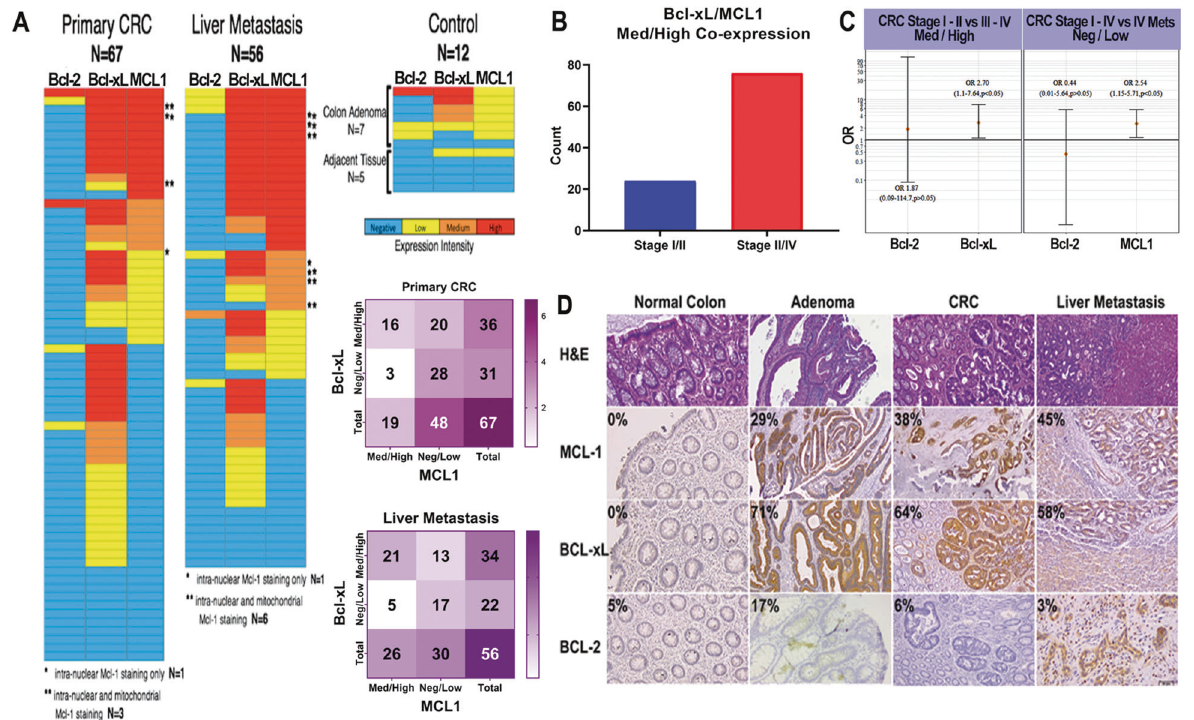
Fig. 5 Co-localization of overexpression MCL1 with Bcl-xL in clinical CRC samples. A Representation of protein expression for primary CRC and liver metastasis tissues. Rows represent individual patients. Primary CRC includes stages 1, 2, 3, and 4. Colon adenomas and adjacent tissues were used as control tissues. Expression patterns (negative, low, medium, and high) are shown for Bcl-2, Bcl-xL, and MCL1. Intra-nuclear MCL1 expression is marked with a single asterisk. Both nuclear and cytoplasmic expressions are marked with two asterisks. Two by two tables represent Bcl-xL vs MCL1 co-overexpression. Staining was categorized as follows: negative/low or medium/high by generating a composite score based on intensity (weak, moderate, and strong) and % positive tumor cells (<30%, 30 – 70%, >70%). Nuclear and/or cytoplasmic MCL1 and cytoplasmic Bcl-xL and Bcl-2 staining were considered positive. Chi-square tests were used to correlate marker expression with tumor location, stage, and grade. B Bar plot representing percentages of Bcl-xL/MCL1 Med/High co-expression, 95% CI (0.32 – 0.71, p < 0.05) in only CRC samples. C On the left: Forest plot representing OR for Bcl-2 Med/High and Bcl-xL Med/High between stage I/II and III/IV. On the right: Forest plot representing OR for Bcl-2 Neg/Low and MCL1 Neg/Low between Stage I − IV and IV Liver Mets. The graph is presented in a log scale. D Representative of primary CRC and mCRC tissues stained for various genes using 3,3 ’ -Diaminobenzidine (DAB) Chromogen (Dako). The intensity of brown color is proportional to increased gene expression and graded: negative, low, medium, and high. Adenomas and normal adjacent tissues were used as positive and negative controls, respectively. Percentages represent only medium/high MCL1, Bcl-xL, and Bcl-2 expression within the